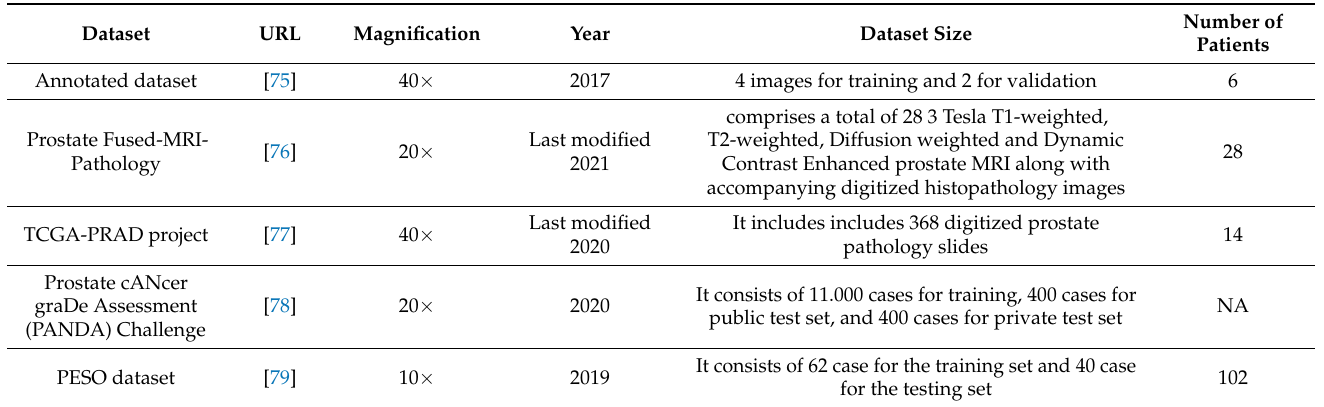
Table 2. Details of publicly available datasets containing prostate histopathology images.